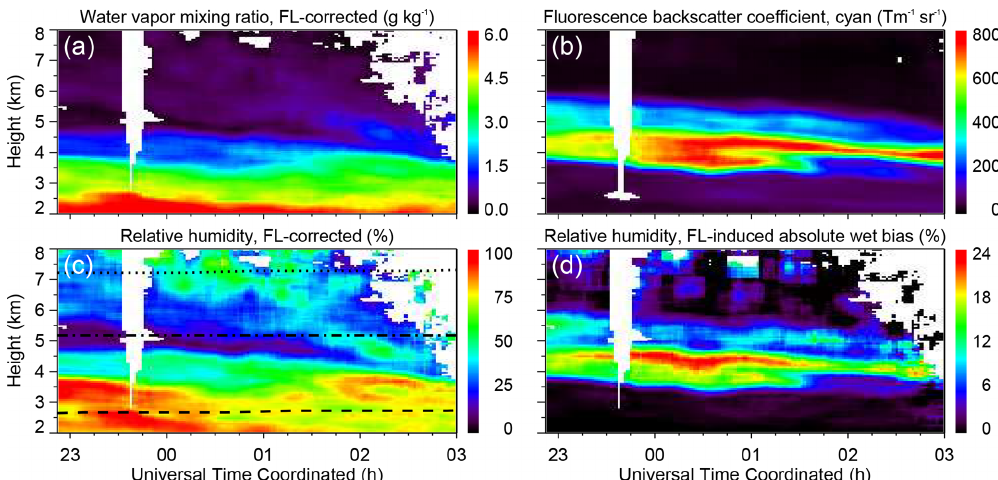
Figure 9. Measurement of (a) water vapor mixing ratio and (c) relative humidity (with respect to water and ice above and below 0 ◦ C, respectively; 0, − 15 and − 30 ◦ C isotherms indicated by black lines) with the RAMSES UVA spectrometer in the night of 9–10 August 2021. The measurements are corrected for aerosol fluorescence. (b) Cyan fluorescence backscatter coefficient and (d) fluorescence-induced absolute wet bias of the spectrometer measurement (difference between measured and corrected relative humidity) are also shown.